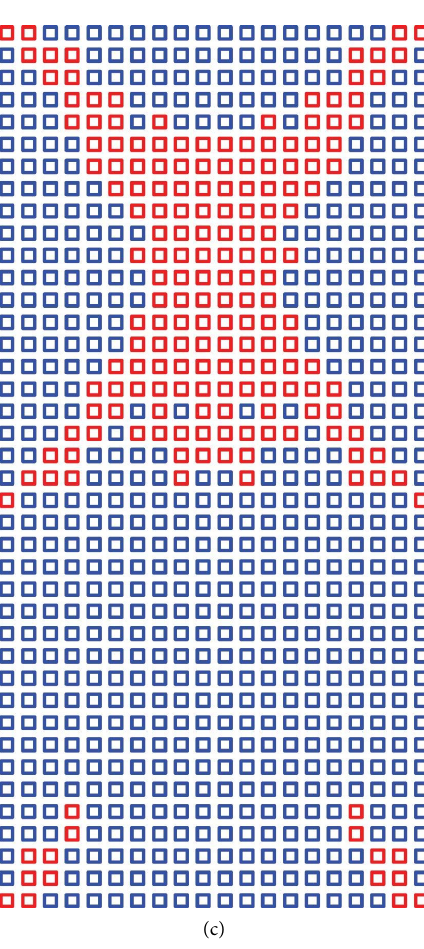
Figure 7: Distributions of the shear band under diferent particle densities: (a) coarse grid model ( Δ x � 2 mm, δ � 2 Δ x � 4mm); (b) fne grid model ( Δ x � 1.333mm, δ � 3 Δ x � 4mm); (c) large horizon model ( Δ x � 2mm, δ � 4 Δ x � 8mm).